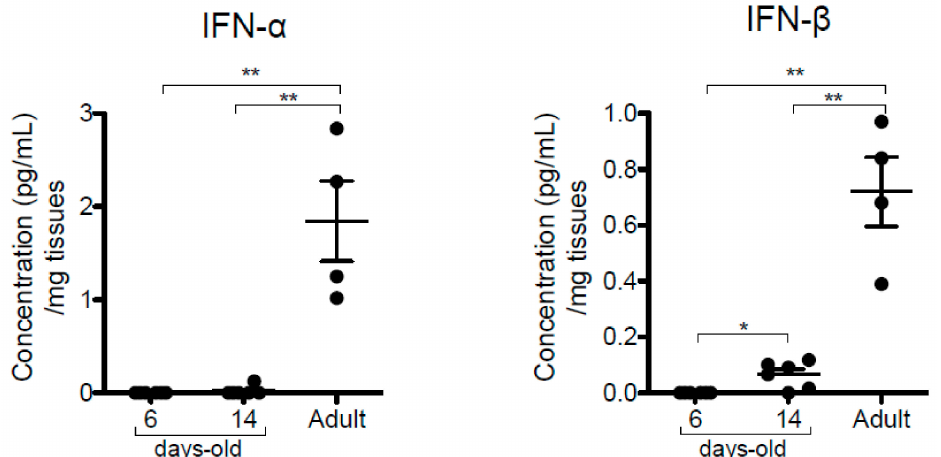
Figure 3. Type-I interferon (IFN-I) antiviral response was not detectable in neonates. Six day-old or 14 day-old neonates and 8 week-old adult mice were infected with RSV-Luc (1.75 × 10 6 pfu / mL, 10 µ L / neonate, 50 µ L / adult). IFN- α and IFN- β production was measured by luminex assays in lung homogenates at 1 d.p.i. Results are expressed as mean of individual ± SEM (one representative experiment of two with n = 5 to 8 mice / group; * p < 0.05; ** p <